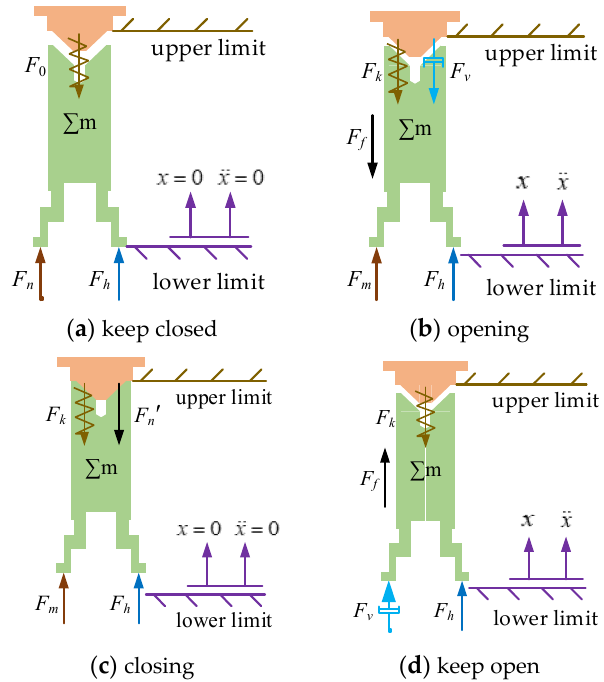
Figure 3. Stress analysis diagram of armature in each